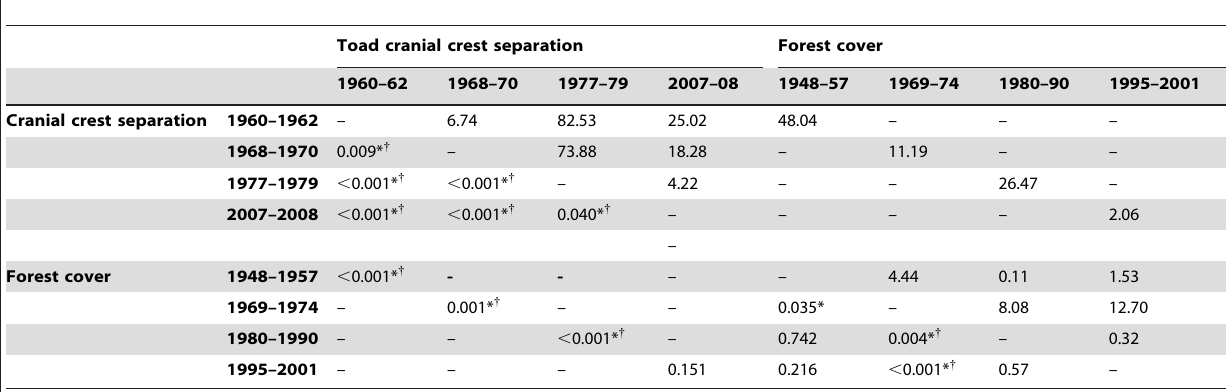
Table 2. Pair-wise tests of coincidence among morphological clines of cranial crest separation in toads.